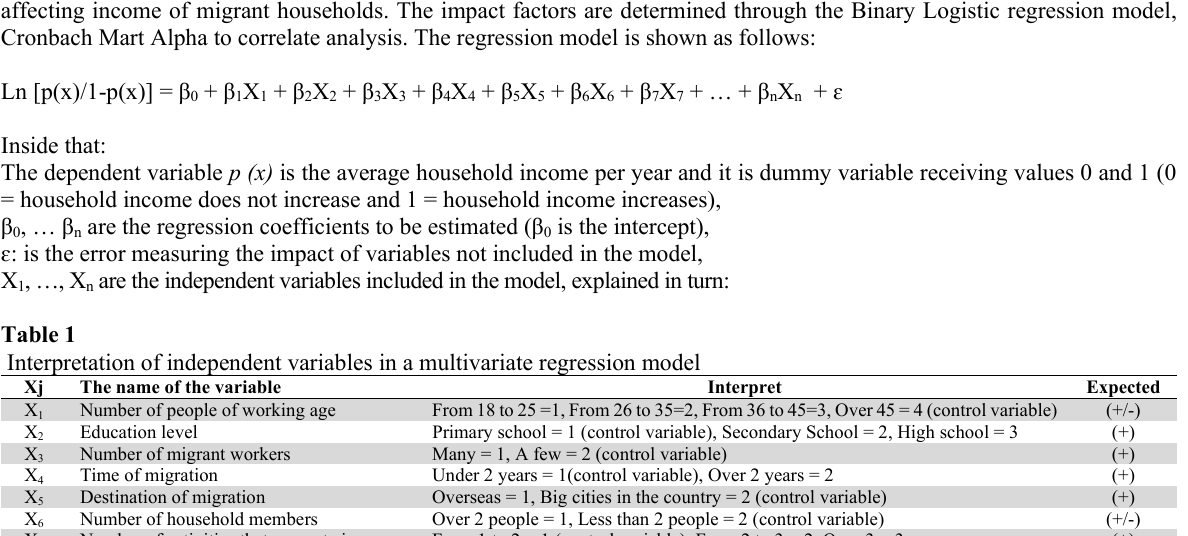
Interpretation of independent variables in a multivariate regression model Xj The name of the variable Interpret Expected X 1 Number of people of working age From 18 to 25 =1, From 26 to 35=2, From 36 to 45=3, Over 45 = 4 (control variable) (+/-) X 2 Education level Primary school = 1 (control variable), Secondary School = 2, High school = 3 (+) X 3 Number of migrant workers Many = 1, A few = 2 (control variable) (+) X 4 Time of migration Under 2 years = 1(control variable), Over 2 years = 2 (+) X 5 Destination of migration Overseas = 1, Big cities in the country = 2 (control variable) (+) X 6 Number of household members Over 2 people = 1, Less than 2 people = 2 (control variable) (+/-) X 7 Number of activities that generate income From 1 to 2 = 1 (control variable), From 2 to 3 = 2, Over 3 = 3 (+) X 8 The support from outside Yes = 1, No = 2 (control variable)